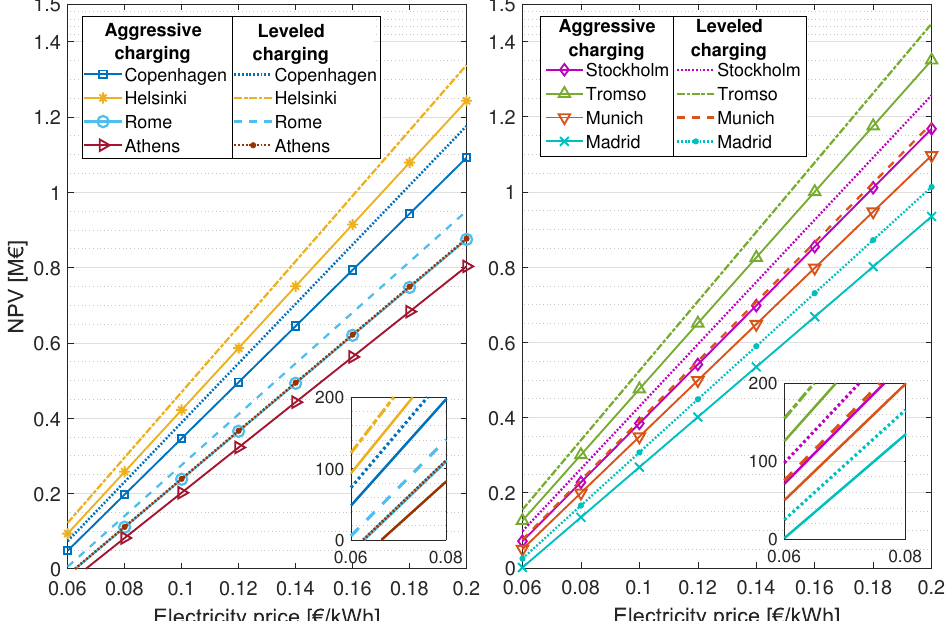
Figure 13. Net present value for selected cities with the SC design at different electricity prices when applying the leveled and aggressive charging